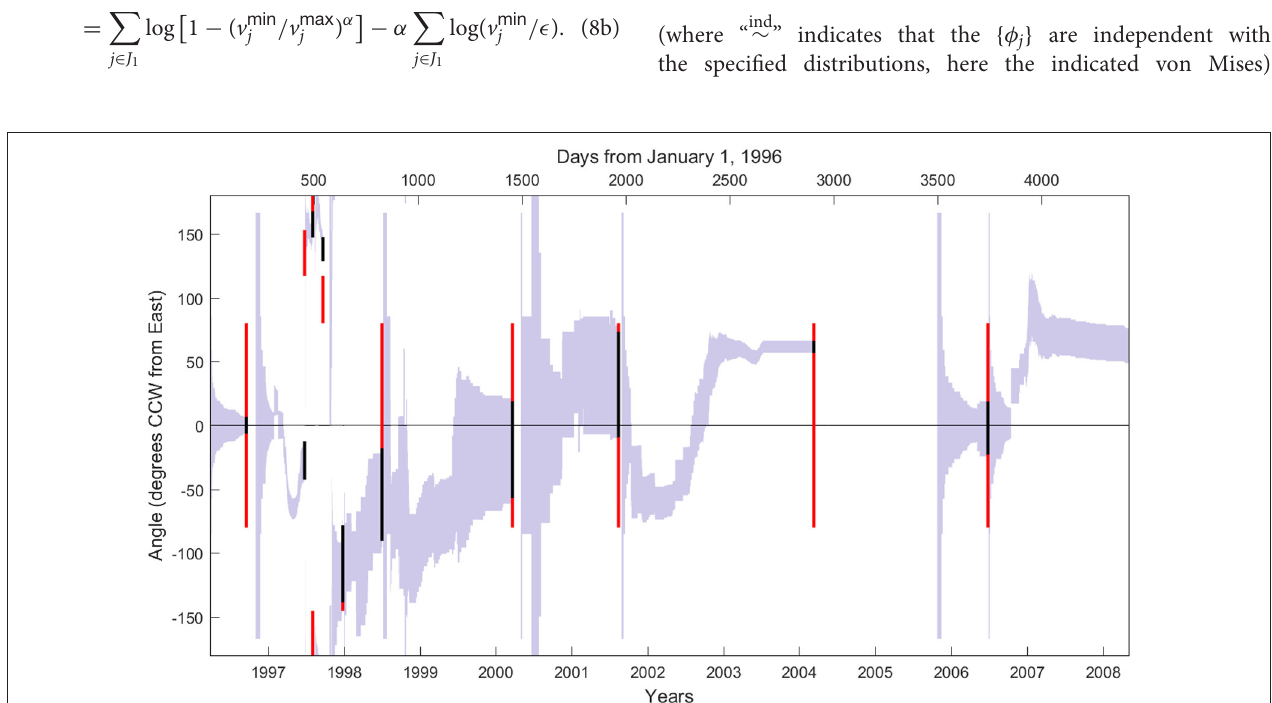
FIGURE 9 | Ninety-five percent credible intervals for centrality parameter µ e at each time τ during epoch ( T e , T e φ j distributions for flow directions (not shown) are much wider, reflecting additional uncertainty about how φ j varies from the center µ e of its distribution. Thick black { } lines indicate 95% intervals for µ e at time T e 1 ending this epoch (and beginning the next), while thick red segments indicate valleys inundated by major flow at time + T e 1 ending the +